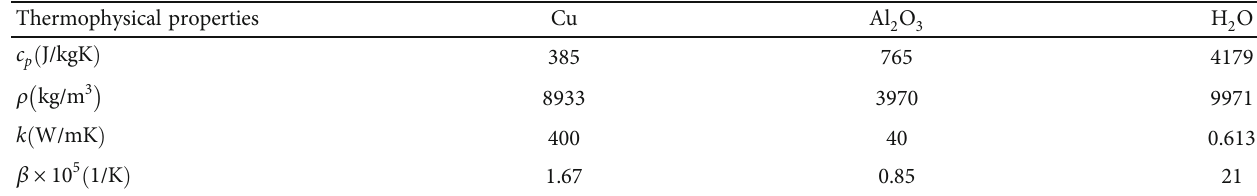
O , H O , and Cu 2 3 2